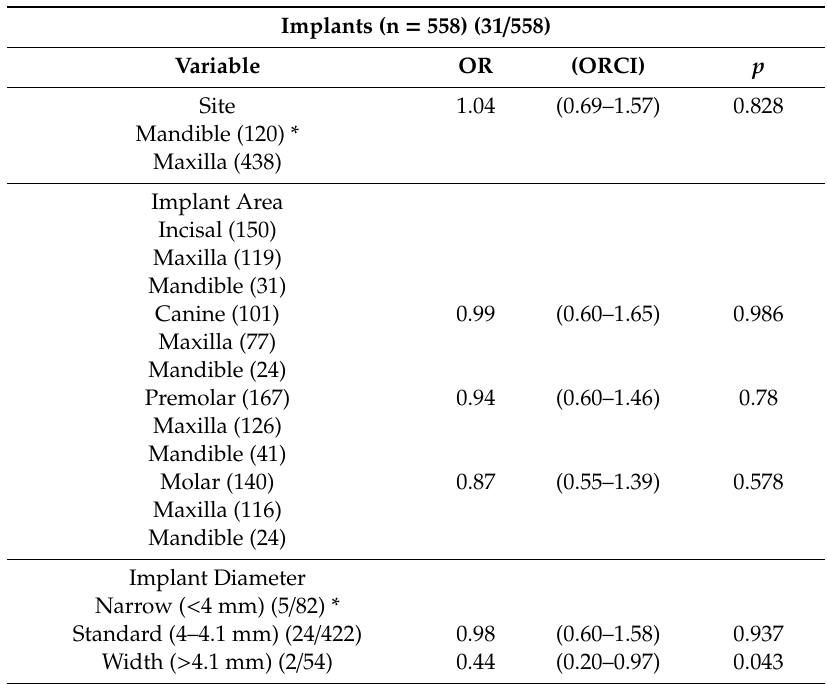
Distribution of mechanical technical complications in the sample in relation to implant-based